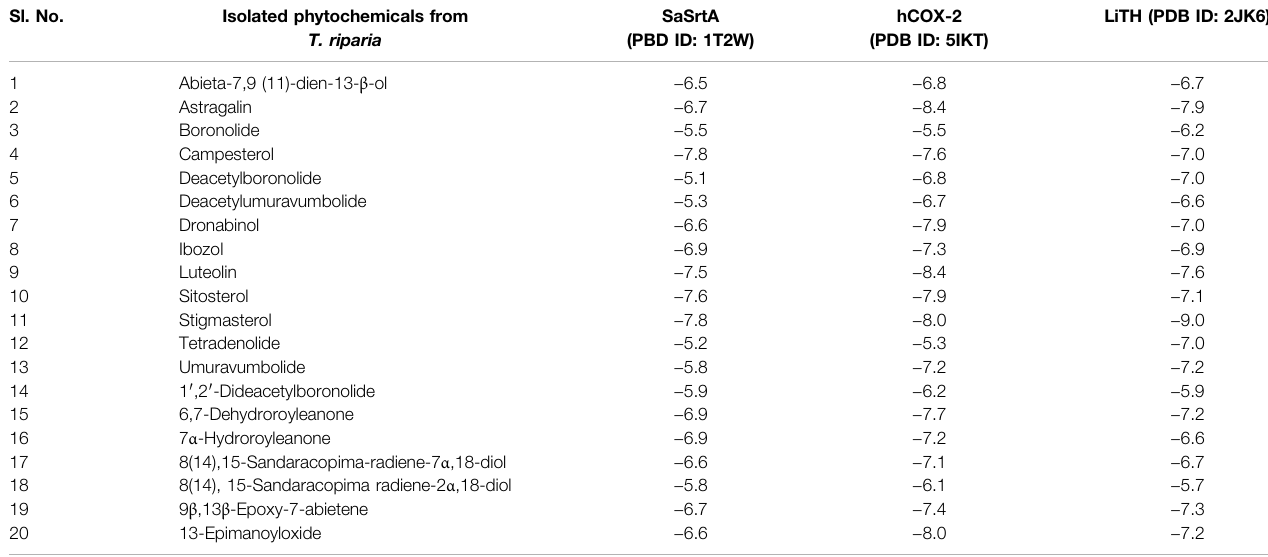
TABLE 4 | Molecular docking study of phytochemicals from T. riparia against three target enzymes potentially important for the antibio fi lm, anticancer and antiparasitic activity. Sl.